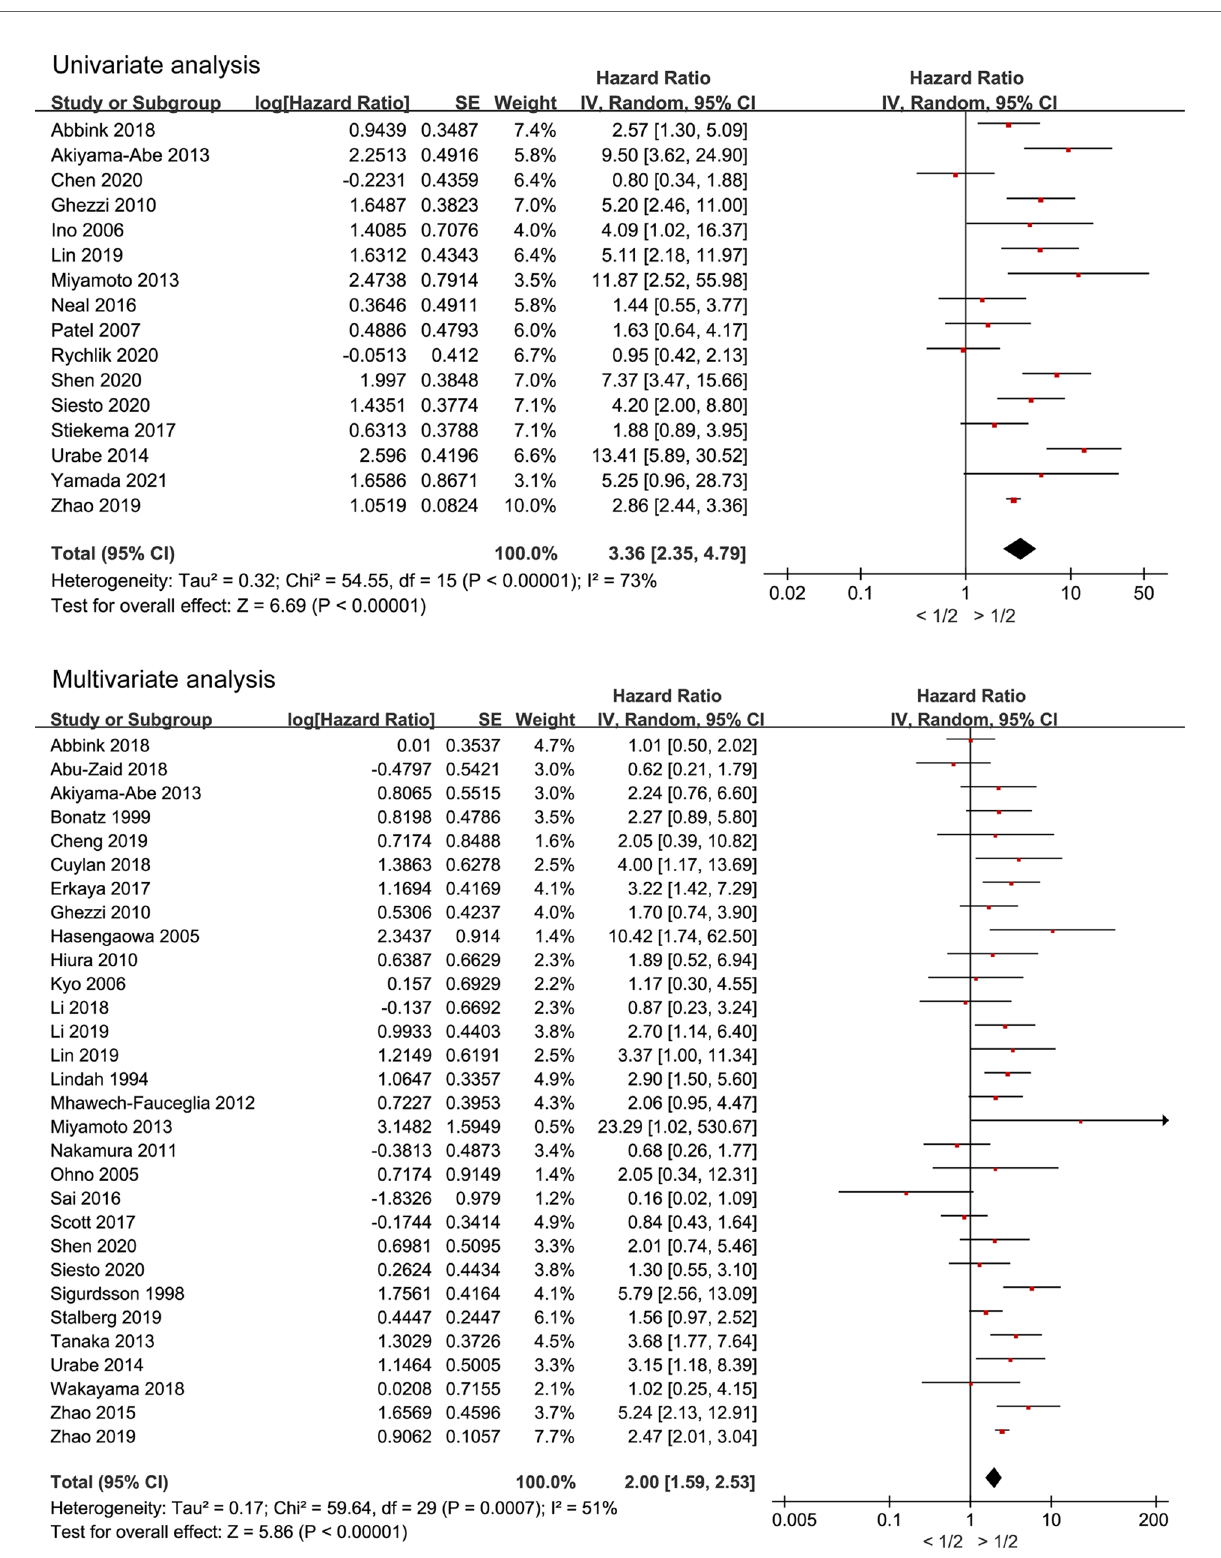
FIGURE 4 | Meta-analysis of the association between myometrial invasion and overall survival in endometrial cancer patients according to HR from univariate or multivariate survival analyses.